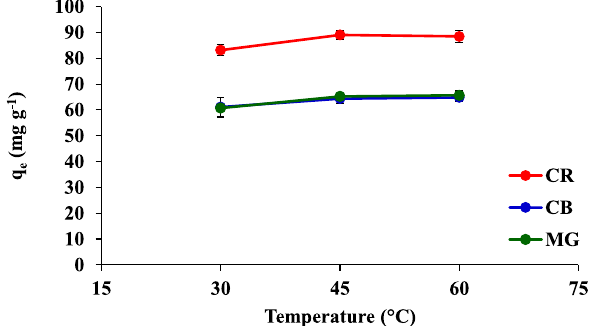
Figure 9. Effect of the temperature on the adsorption of CR, CB, and MG.